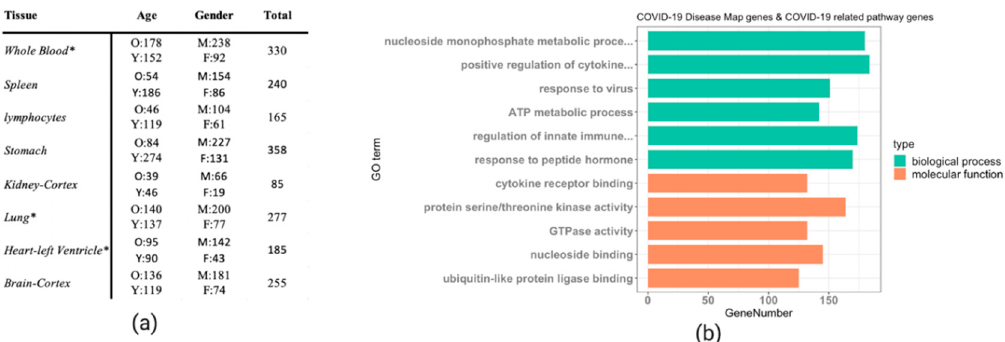
Figure 1. ( a ) Summary of the GTEx samples implemented the DeCovid app. O: old age (age ≥ 60); Y: young age (age < 60); M: males, F: females. * indicates that only a subpart of the original GETx data was used due to quality control issues. ( b ) Gene ontology enrichment analysis of the 1523 COVID-19 related pathways genes and 802 COVID-19 Disease Map genes. The most enriched GO terms by category are shown.